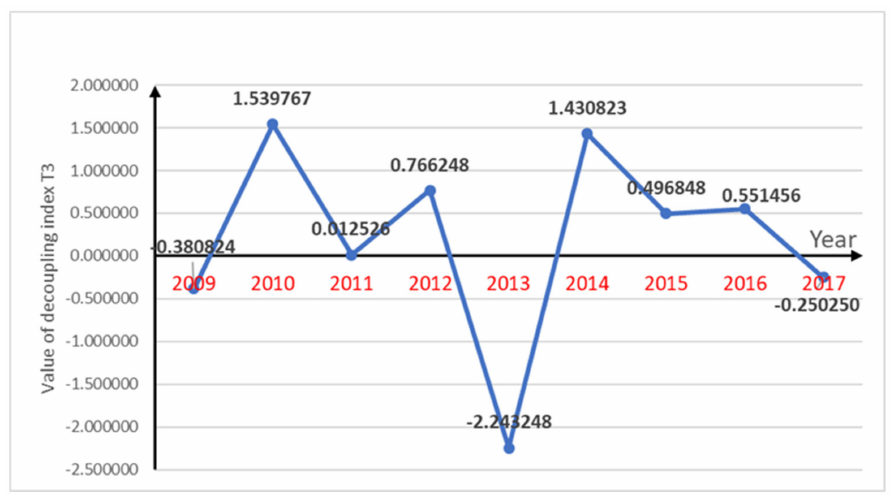
Figure 4. Decoupling index changes of T 3 along with period of